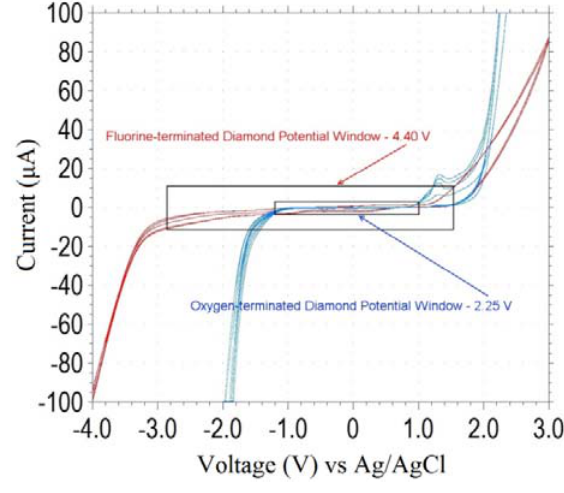
Figure 9. Cyclic voltammogram comparing the potential windows of oxygen-terminated diamond and fl uorine-terminated diamond in 1 M